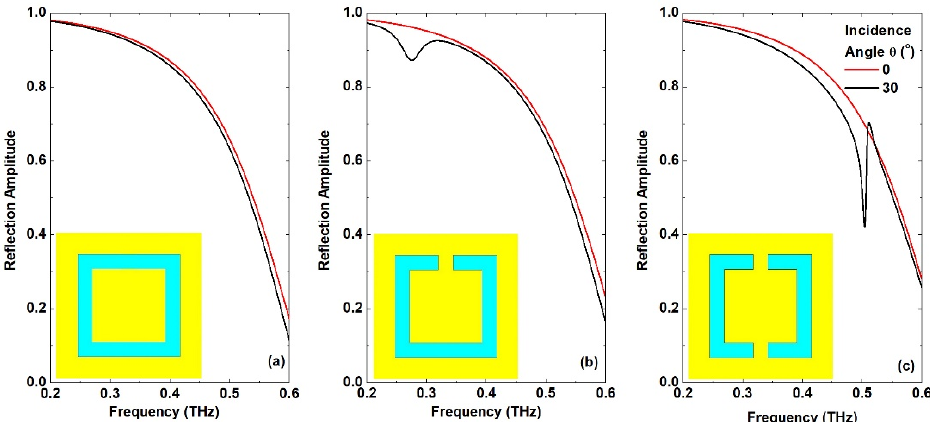
Figure 7. Reflection spectra of ( a ) symmetric complementary rectangular resonator, ( b ) symmetric complementary split rectangular resonator with one microstrip line on the top slot, and ( c ) symmetric complementary split rectangular resonator with two microstrip lines on the top and bottom slots.